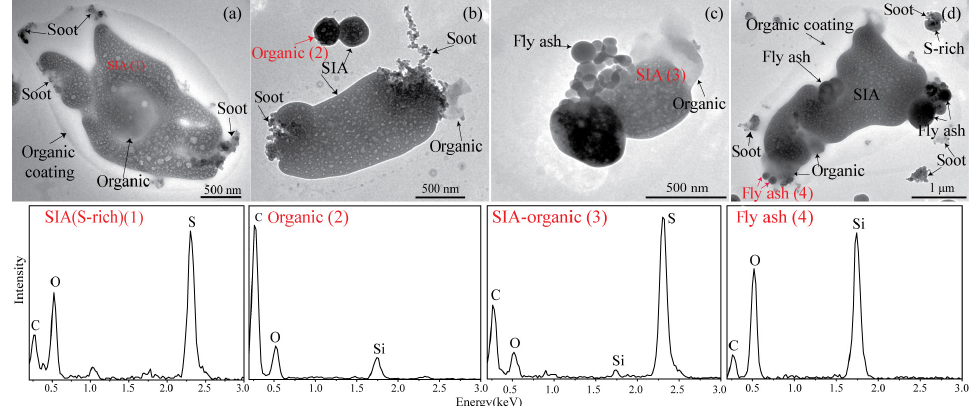
Figure 5. TEM images of (a) SIA–soot–OC (visible) with organic coating on 16 September. (b) SIA–soot–OC on 14 September. (c) SIA–fly ash–OC on 5 October. (d) SIA–fly ash–soot–OC (visible) with organic coating on 16 September. EDS spectra shows elemental composition of each particle type in each TEM image.